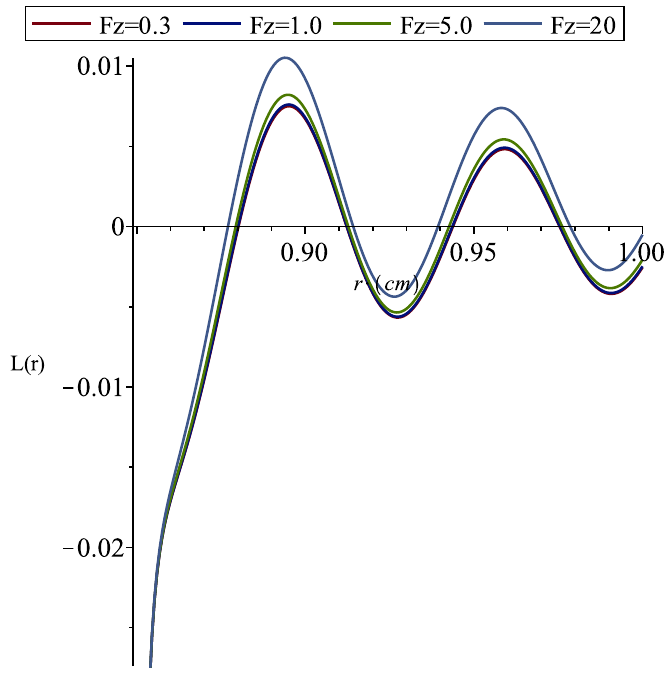
Figure 7. L ( r ) versus r , for α = − 10,000 corresponding to Figure 4 at different values of Fz .